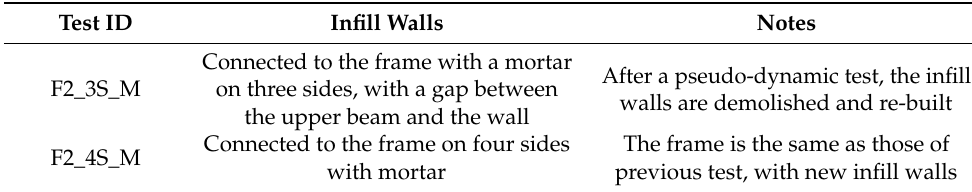
Table 1. Test description for specimen